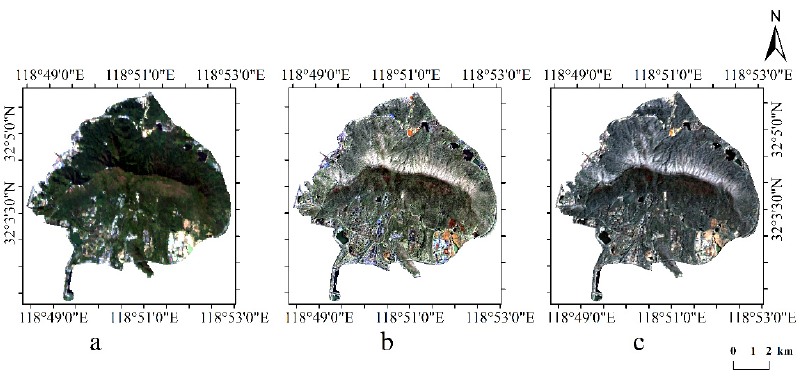
Figure 2. Images of different fusion methods (( a ): original image; ( b ): Gram-Schmidt fusion image; ( c ): Harmonic analysis fusion image). Table 3. Evaluation of the integration degree of the fused spatial information.